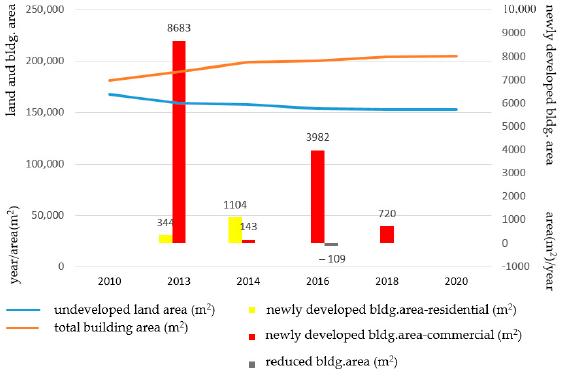
Figure 11. Newly added or developed area of building types around Chung Yuan Eco Pond Park.